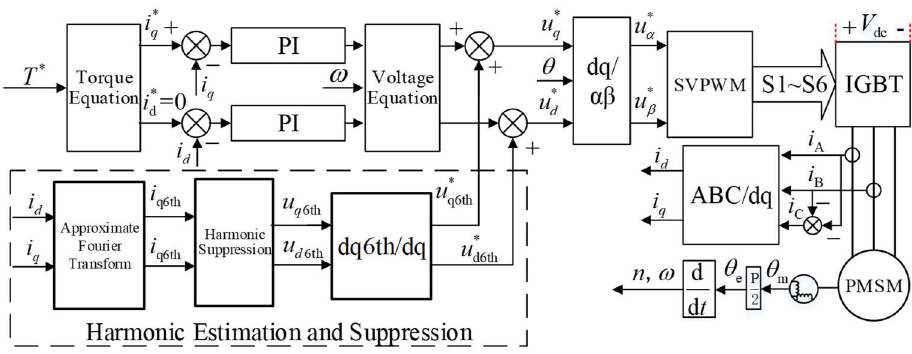
Figure 11. Block diagram of the compensation algorithm for the nonlinearity of the inverter.